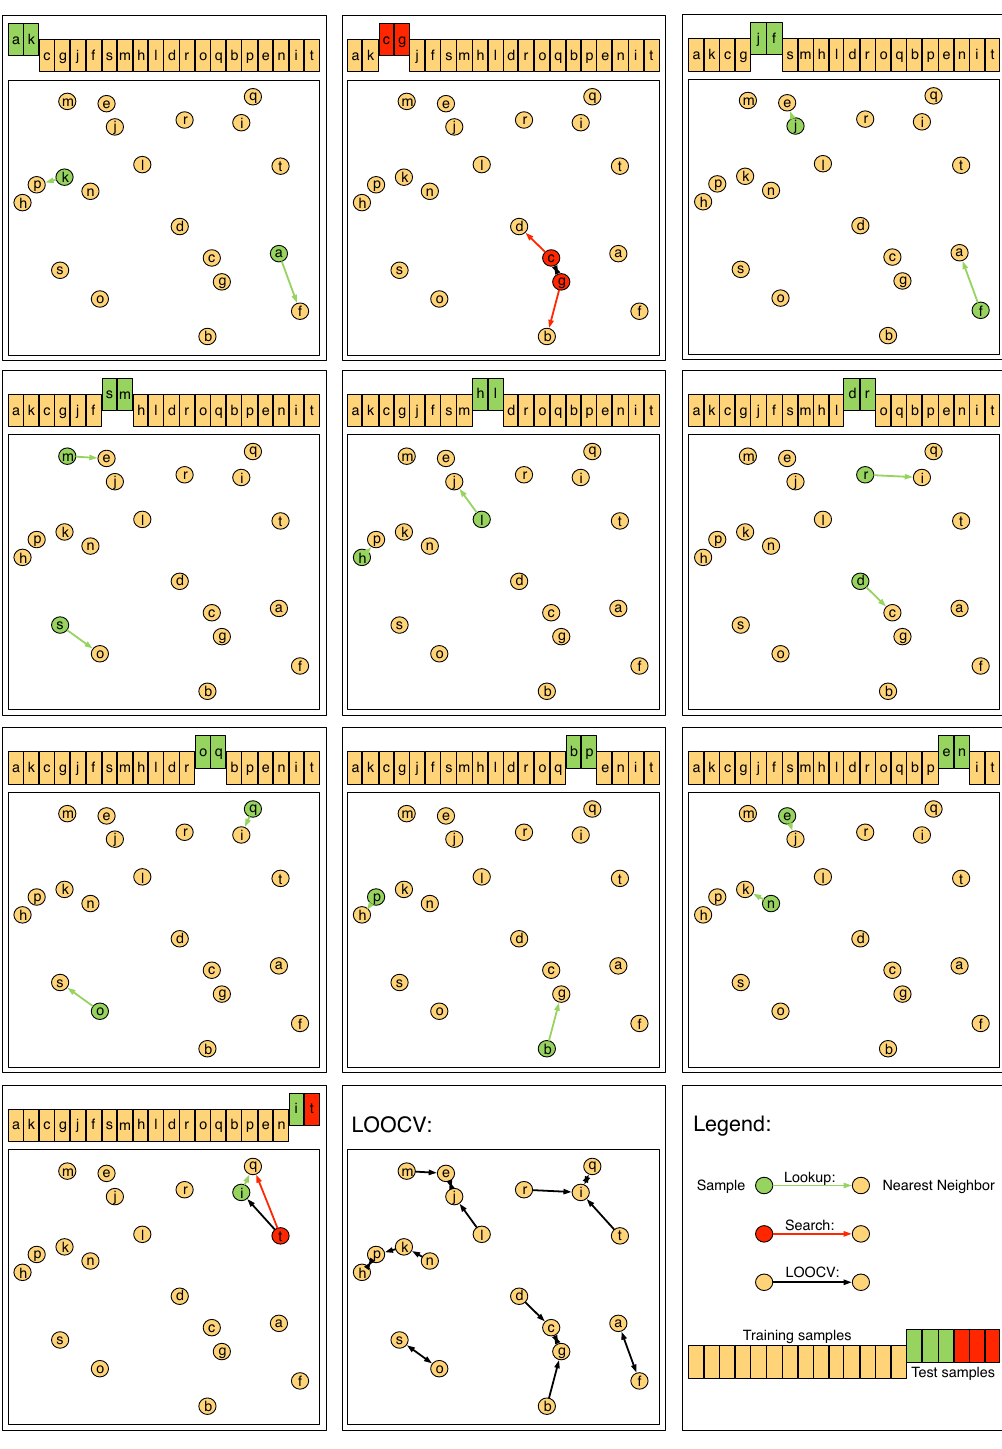
Figure 3. Fast cross validation of a k -NN: The figure shows the relationship of a leave-one-out cross validation (LOOCV) and a f -fold cross validation ( f = 10 , 10-fold CV) for the example of a 1-NN classifier. A dataset of twenty samples is analysed (circles). The center panel at the bottom shows the resulting neighborhood graph of the LOOCV. Each sample is connected with its global nearest neighbor (sample → neighbor). The other panels show the individual classification experiments of the 10-fold CV. For each experiment, only the training samples and the current test sample are available. If the global nearest neighbor of the test sample is included in the training set, the search for the nearest neighbor can be replaced by a look up (green). Otherwise, the training set has to be screened